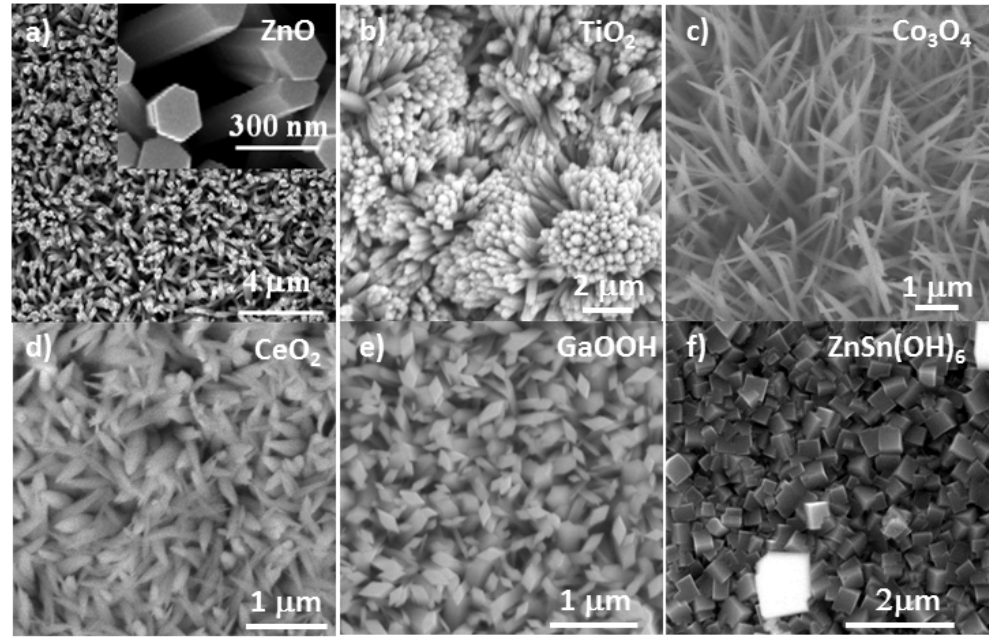
Figure 1. A set of SEM images displaying the single-component nanostructure templates made by solution phase process ( a ) ZnO nanowire arrays; ( b ) TiO ( c ) Co O nanowire arrays; ( d ) CeO 3 4 ( f ) ZnSn(OH) 6